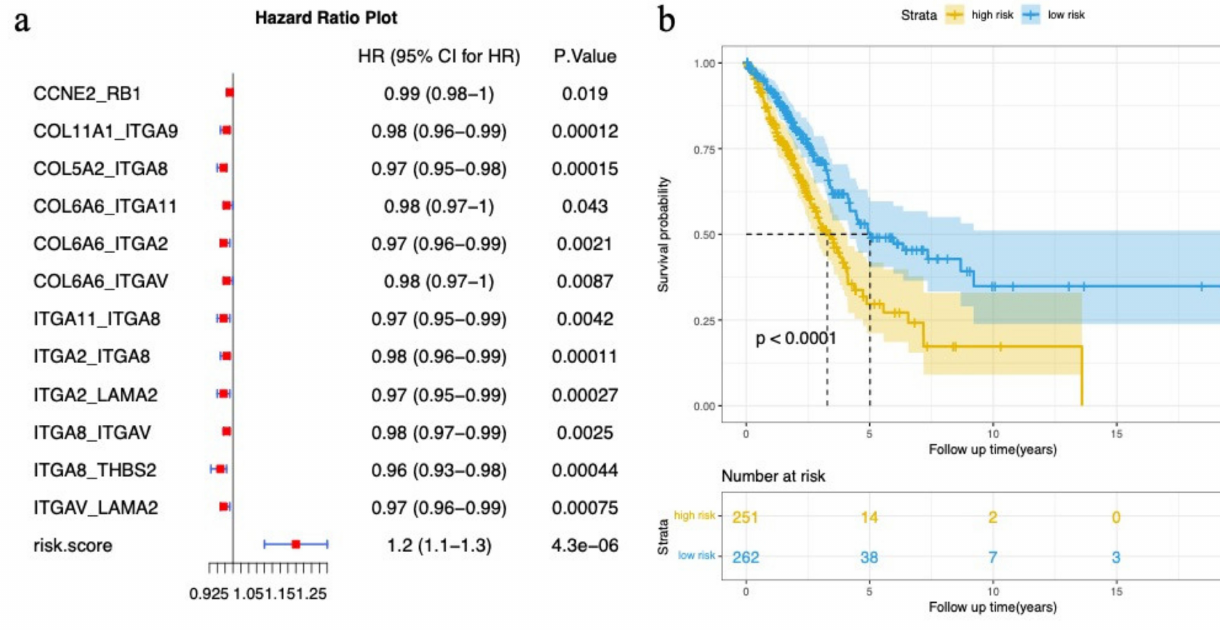
Figure 6. Results of survival analysis of edges. ( a ) Forest plot of 12 edges in LUAD selected by the univariate Cox proportional hazards regression model; ( b ) Kaplan–Meier survival curves of two patient